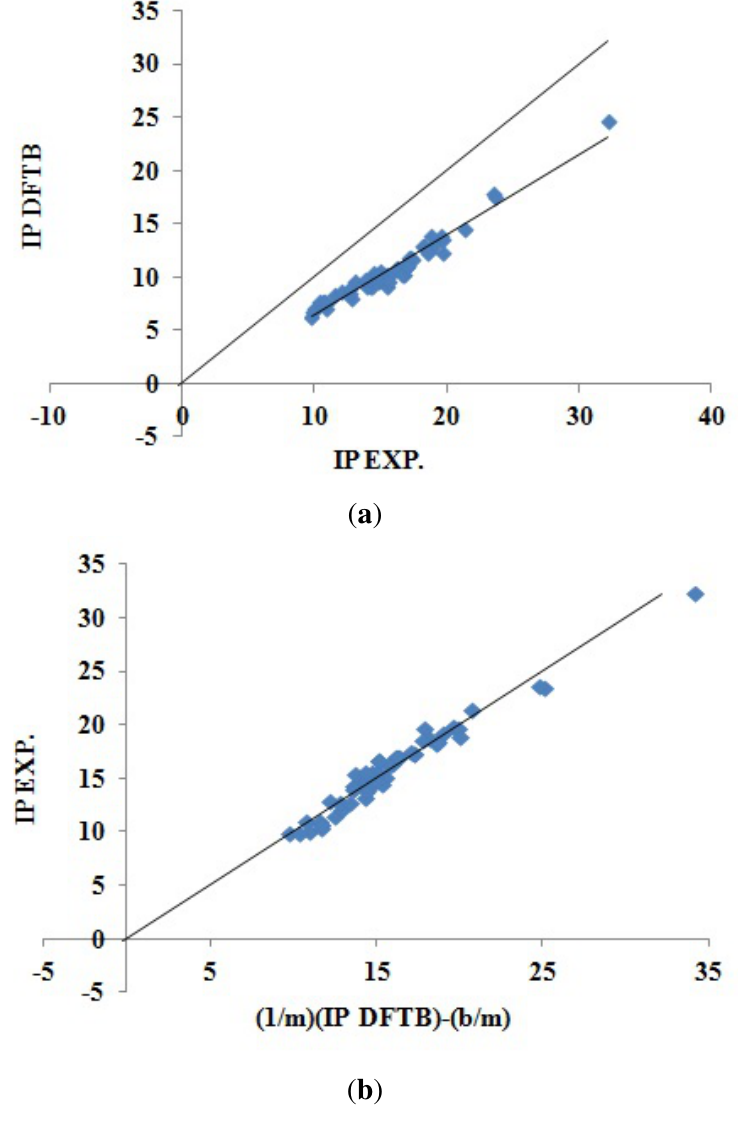
Figure 5. Correlation plot for DFTB “Koopmans’ theorem IPs” versus experimental IPs. ( a ) Correlation plot for DFTB “Koopmans’ theorem IPs” versus experimental IPs; ( b ) inversion plot for the same data constructed using Equation (40) to show the “predictive ability” of the DFTB least squares fit. The units for both axes in these plots are in